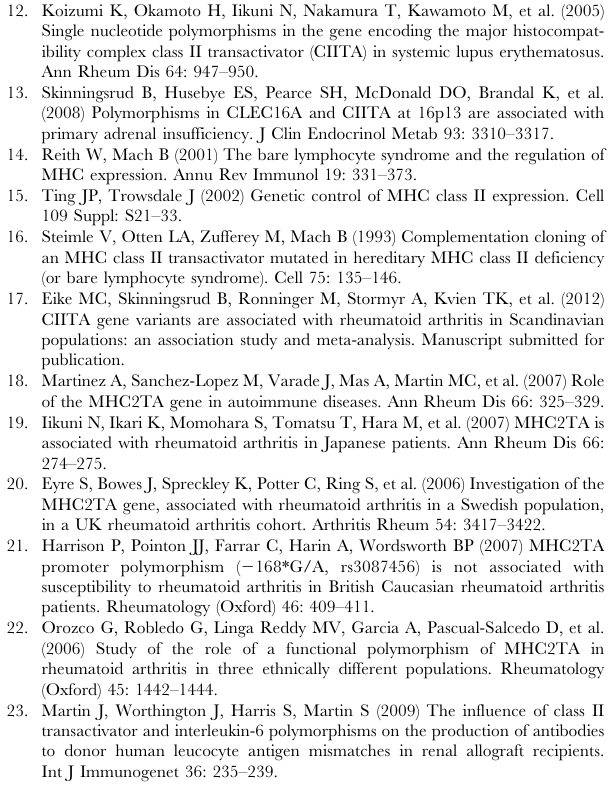
Table S3 Additional data from association analysis. P values were calculated with trend test in Plink (http://pngu.mgh.